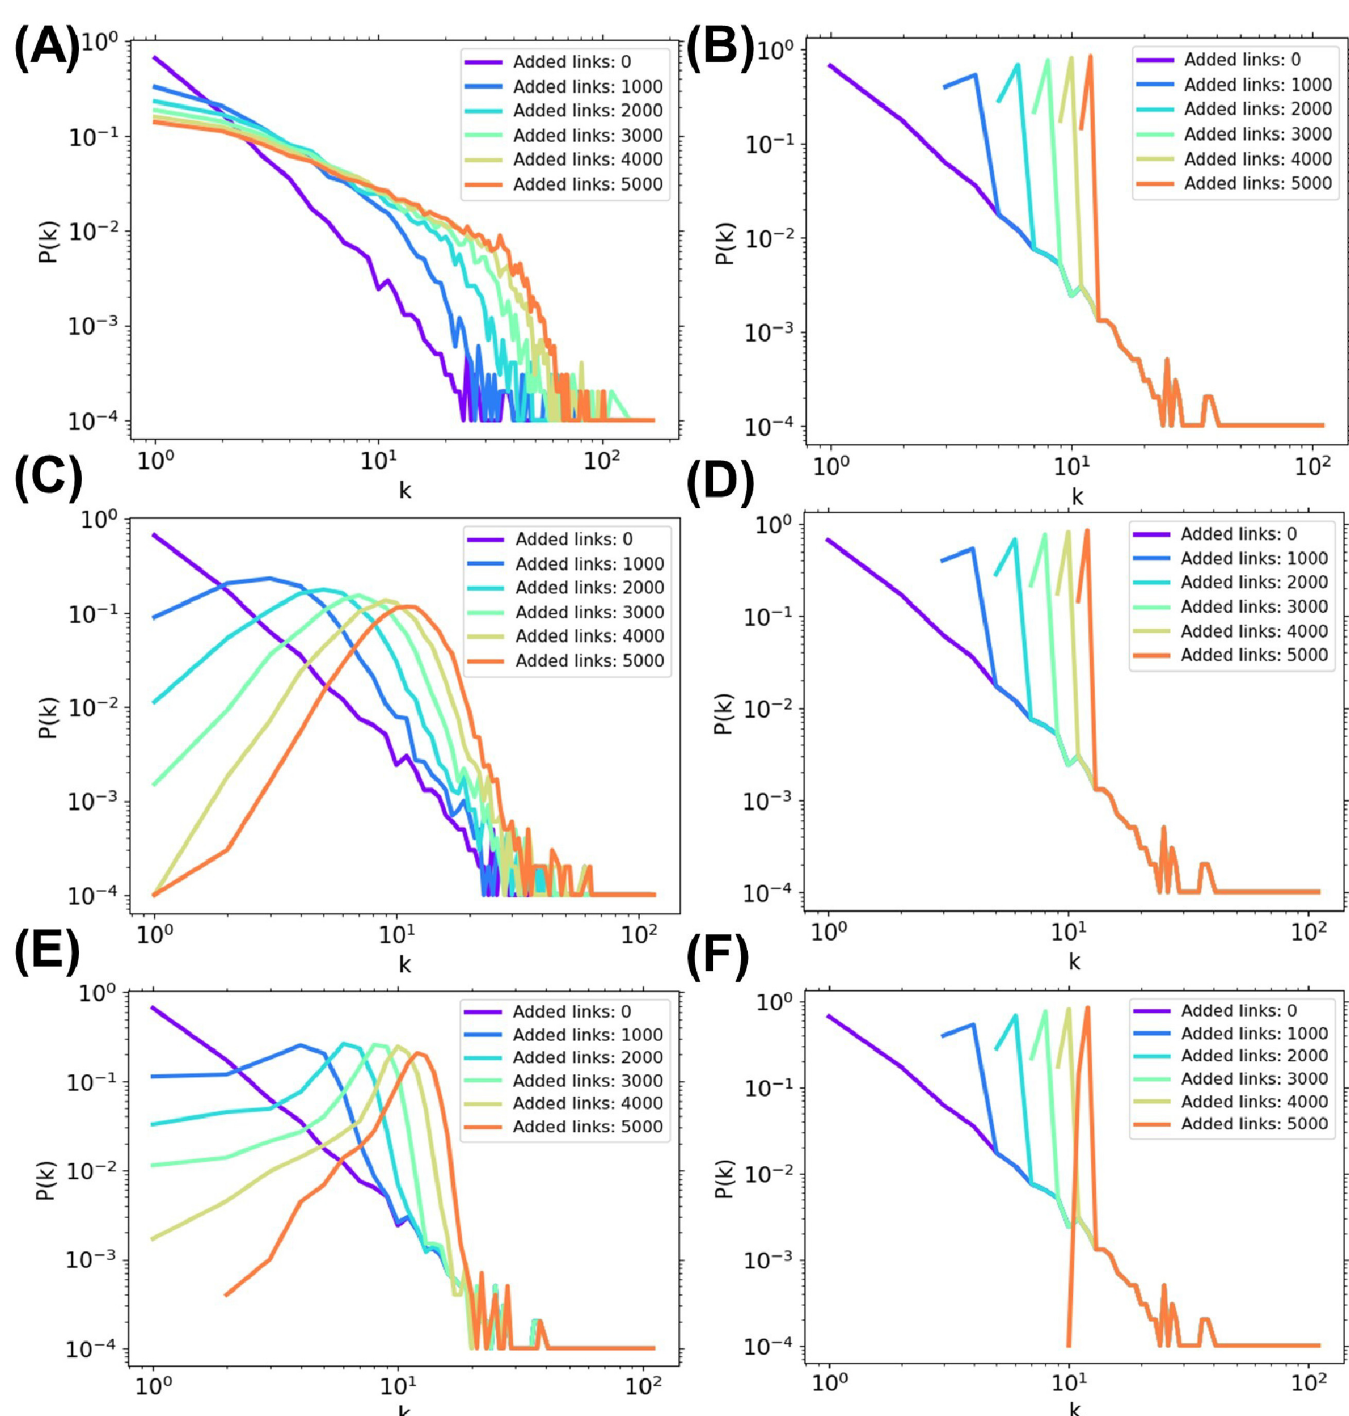
Fig 7. Degree distributions after adding links to SF networks. The LongAdd method adds links to nodes with lower degrees, while the ShortAdd method adds links to nodes with middle to higher degrees. The results are shown for by (A) ShortAdd, (B) min- k ShortAdd, (C) RandAdd, (D) min- k RandAdd, (E) LongAdd, and (F) min- k LongAdd methods, respectively. The initial networks are SF networks with N = 1000 and h k i = 2.